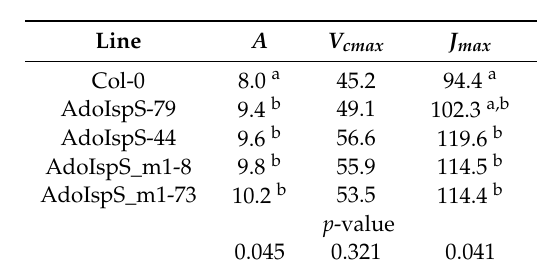
Table 1. Photosynthetic to sub-stomatal CO 2 concentration response curve ( A / C i ) output for the wild-type Col-0 and transgenic lines. Data were collected over Experiments 2 and 3 on control plants with a Licor 6400XT. Parameter estimation was carried out as described by [16]. Values are means ± standard error of the means ( n = 4 to 5) and analyzed with one-way ANOVA while means separation was carried out by Fisher’s